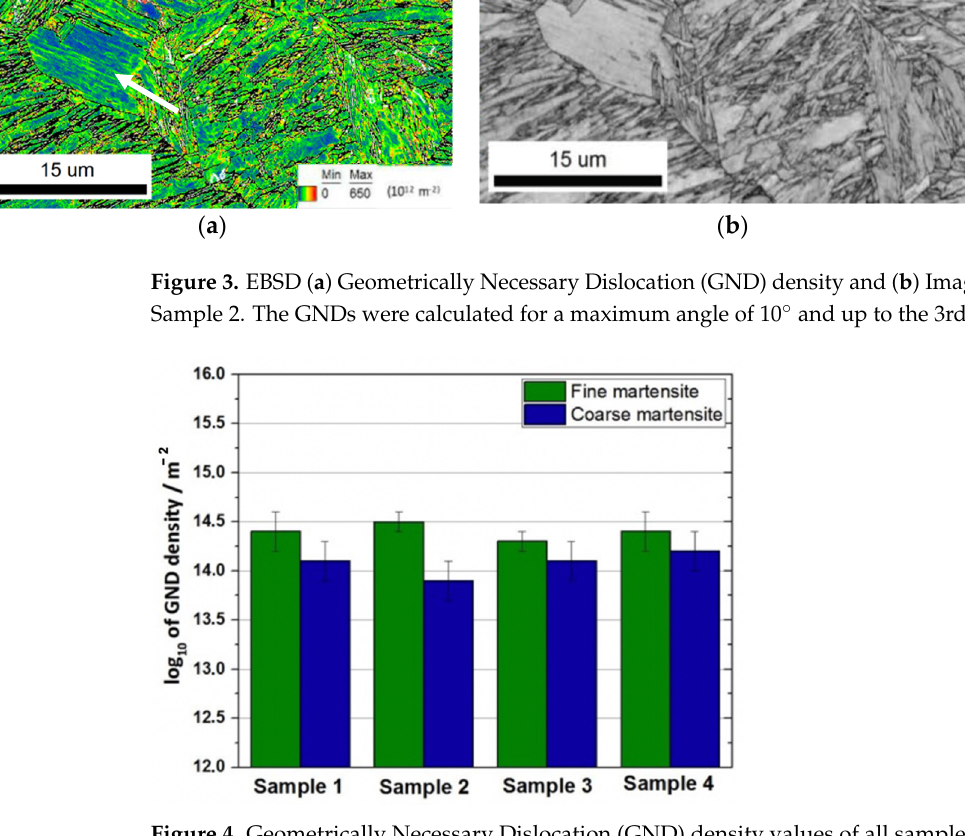
Figure 4. Geometrically Necessary Dislocation (GND) density values of all samples.